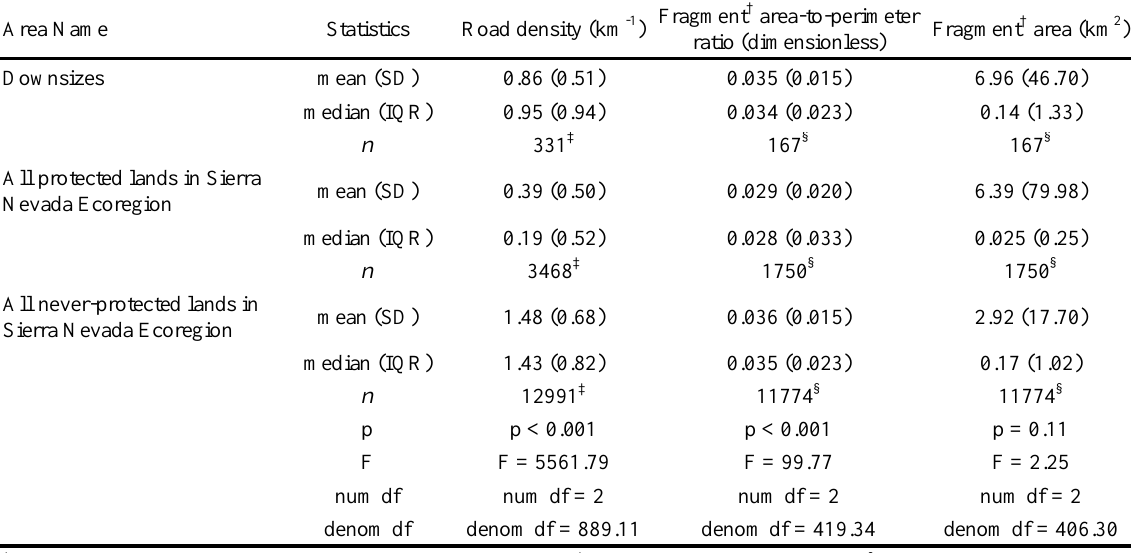
Table 3. Habitat fragmentation indicators at the Ecoregional scale for forested lands; results of Welch’s ANOVA tests. See Table A1.7 for results of post hoc